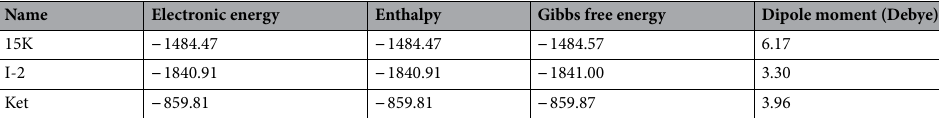
Table 2. Electronic energy, enthalpy, Gibbs free energy (in Hartree), and dipole moment (Debye) of 15K, ketorolac, and inhibitor 2. Ket Ketorolac, I-2 Inhibitor